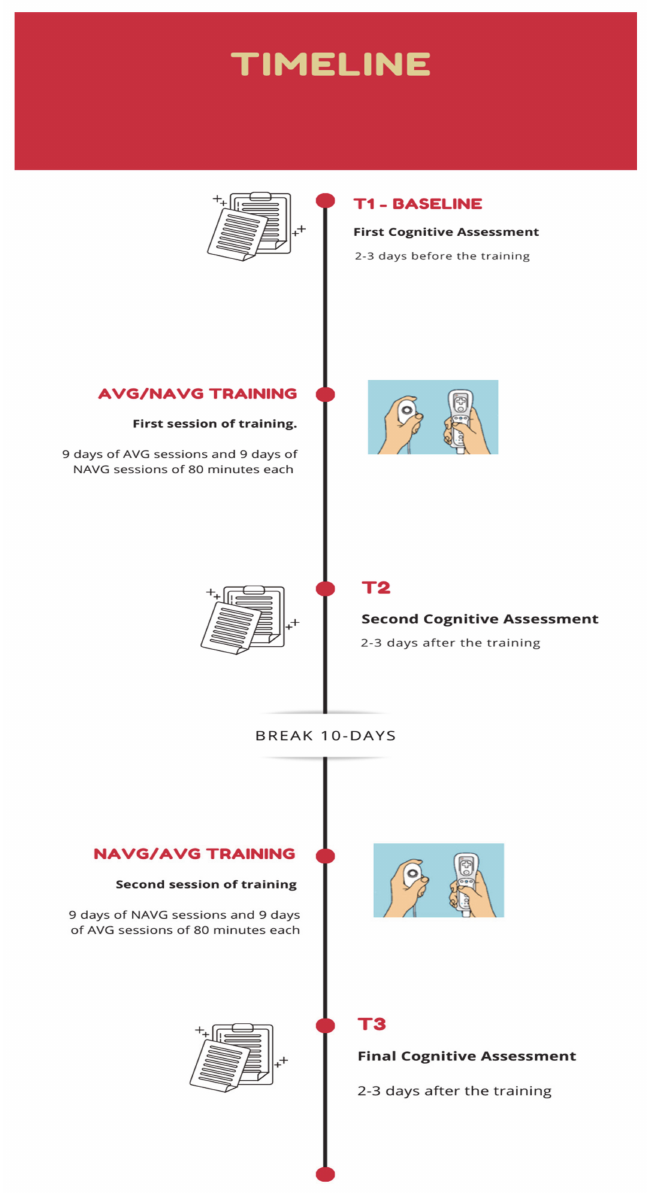
Figure 2. Schematic representation of the timeline of the